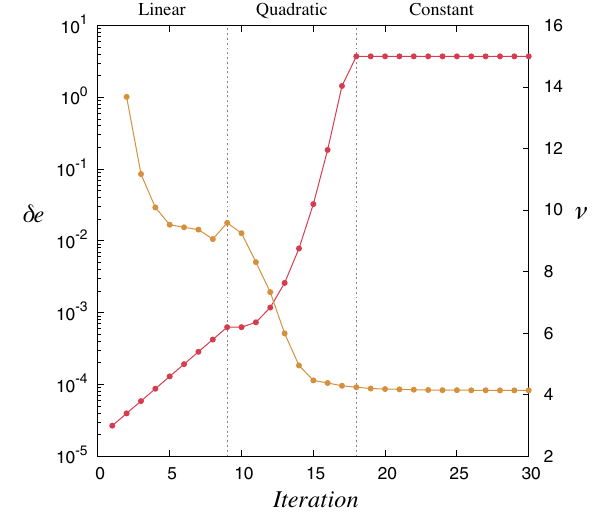
FIG. 15. Penalty parameter ν (red) and energy (yellow) with respect to the number of iterations for a typical LGT simulation. The energy is plotted here as a deviation δ e from the ground-state energy obtained with highest bond dimension available. We start with linearly increasing ν . When the energy increases, we change to a quadratic driving regime with zero gradient at the transition point. Finally, we reach a predefined maximum value for ν .